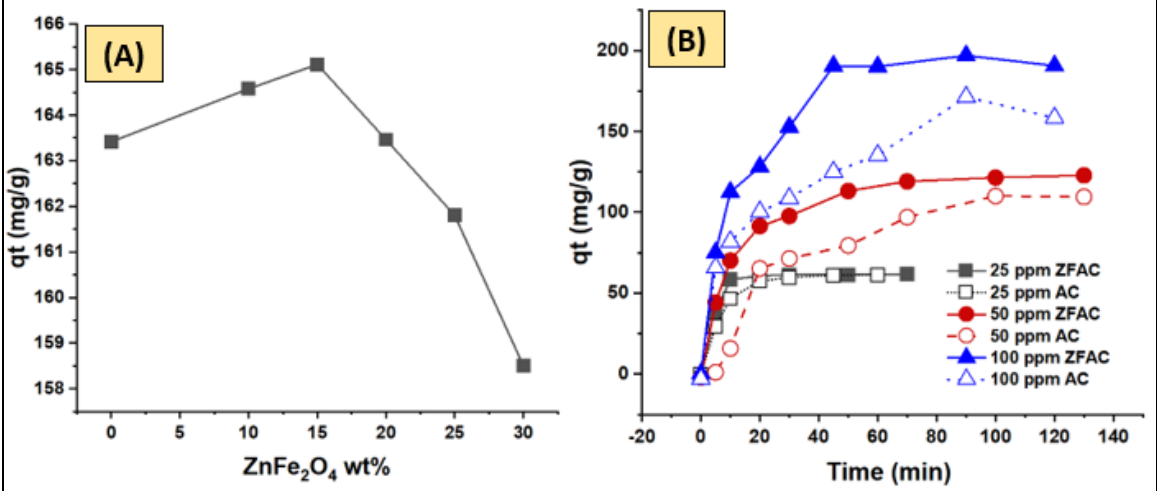
Figure 8. ( A ) Adsorption performance of various ZnFe 2 O 4 /activated carbon (ZFAC) nanocomposites. ( B ) Time profile of crystal violet (CV) (25, 50, and 100 ppm) adsorption onto AC and ZFAC adsorbents.